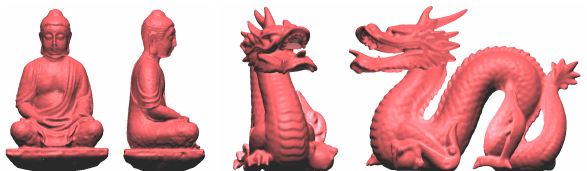
Figure 3. The two test objects: On the left our Buddha statue, scanned with a high resolution 3D scanner and meshed. On the right, the Stanford Dragon meshed by (Rodol`a et al., 2013).